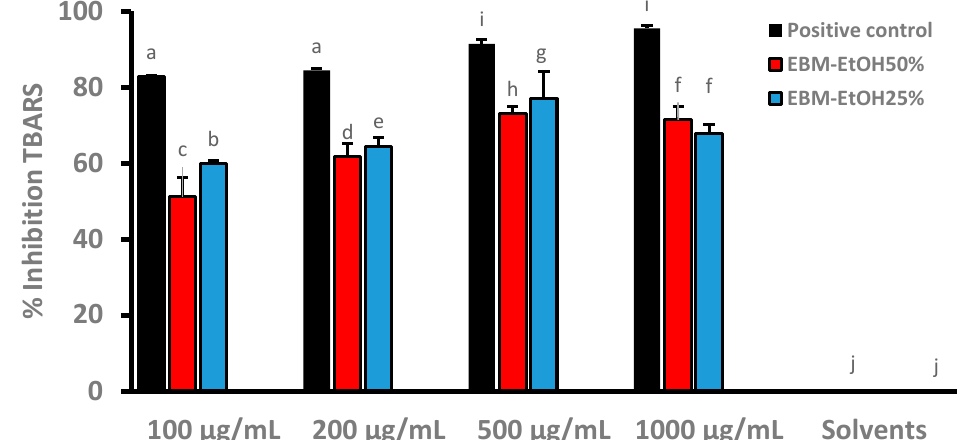
Figure 4. Inhibition of lipid peroxidation in vitro of EBM-EtOH25% and EBM-EtOH50%. Results for positive control butylhydroxytoluene (BHT) and negative control solvents (EtOH25% and EtOH50%) can be seen, as well as the results for EBM (extracts of Baccharis macrantha ). Results are presented as Mean ± SD ( n = 3) and were evaluated by one-way Anova and Tukey test ( p < 0.05). Statistical differences are indicated with different letters.